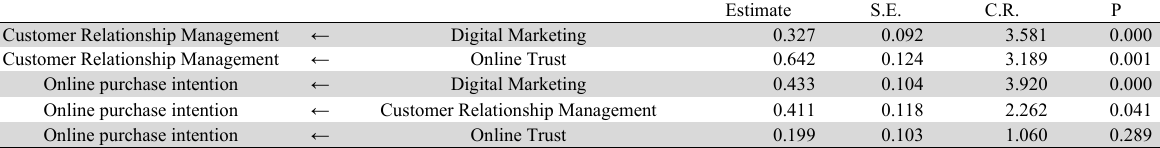
Results of hypothesis testing using regression weights